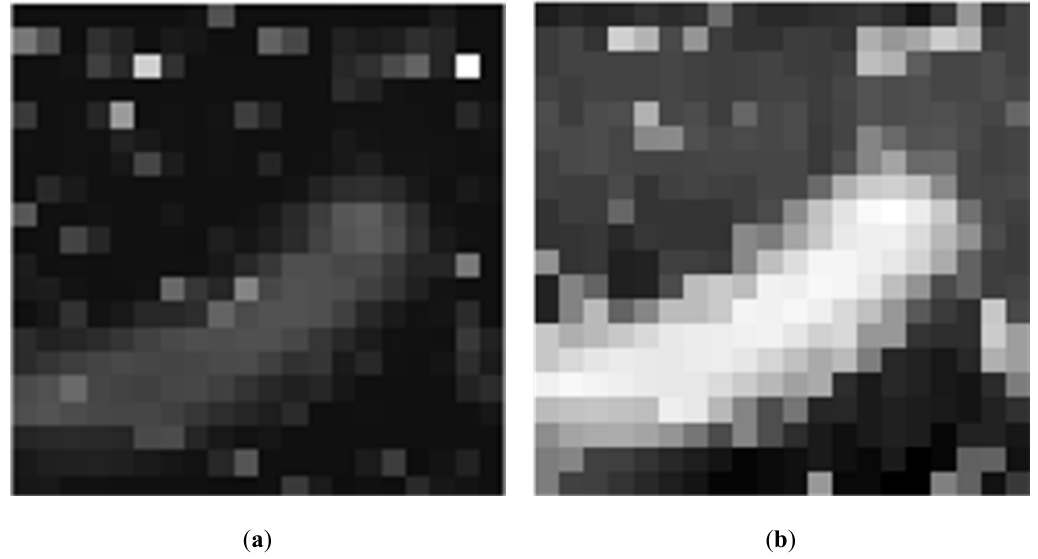
Figure 5. ( a ) represents the original grayscale cell image after extracting the peak. ( b ) represents the Figure which has been enhanced by the Retinex